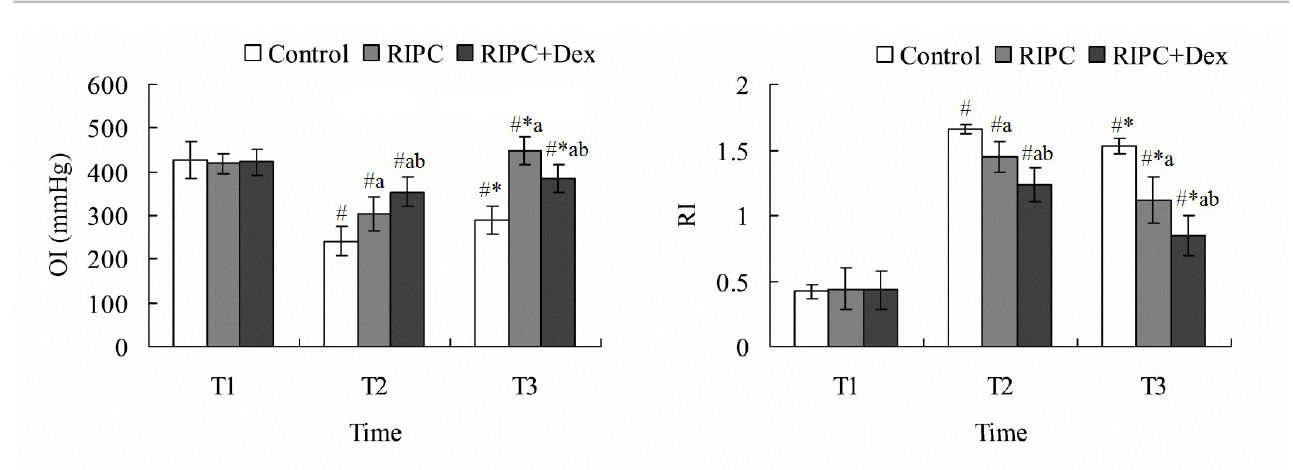
FIGURE 1 - Comparison of OI and RI among three groups. # P < 0.05 compared with T1; * P < 0.05 compared with T2; a P < 0.05 compared with control group; b P < 0.05 compared with RIPC group. OI, oxygenation index; RI, respiratory